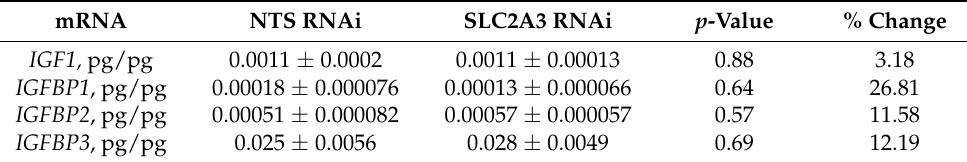
Table 5. Placental insulin-like growth factor mRNA concentrations (75 dGA).